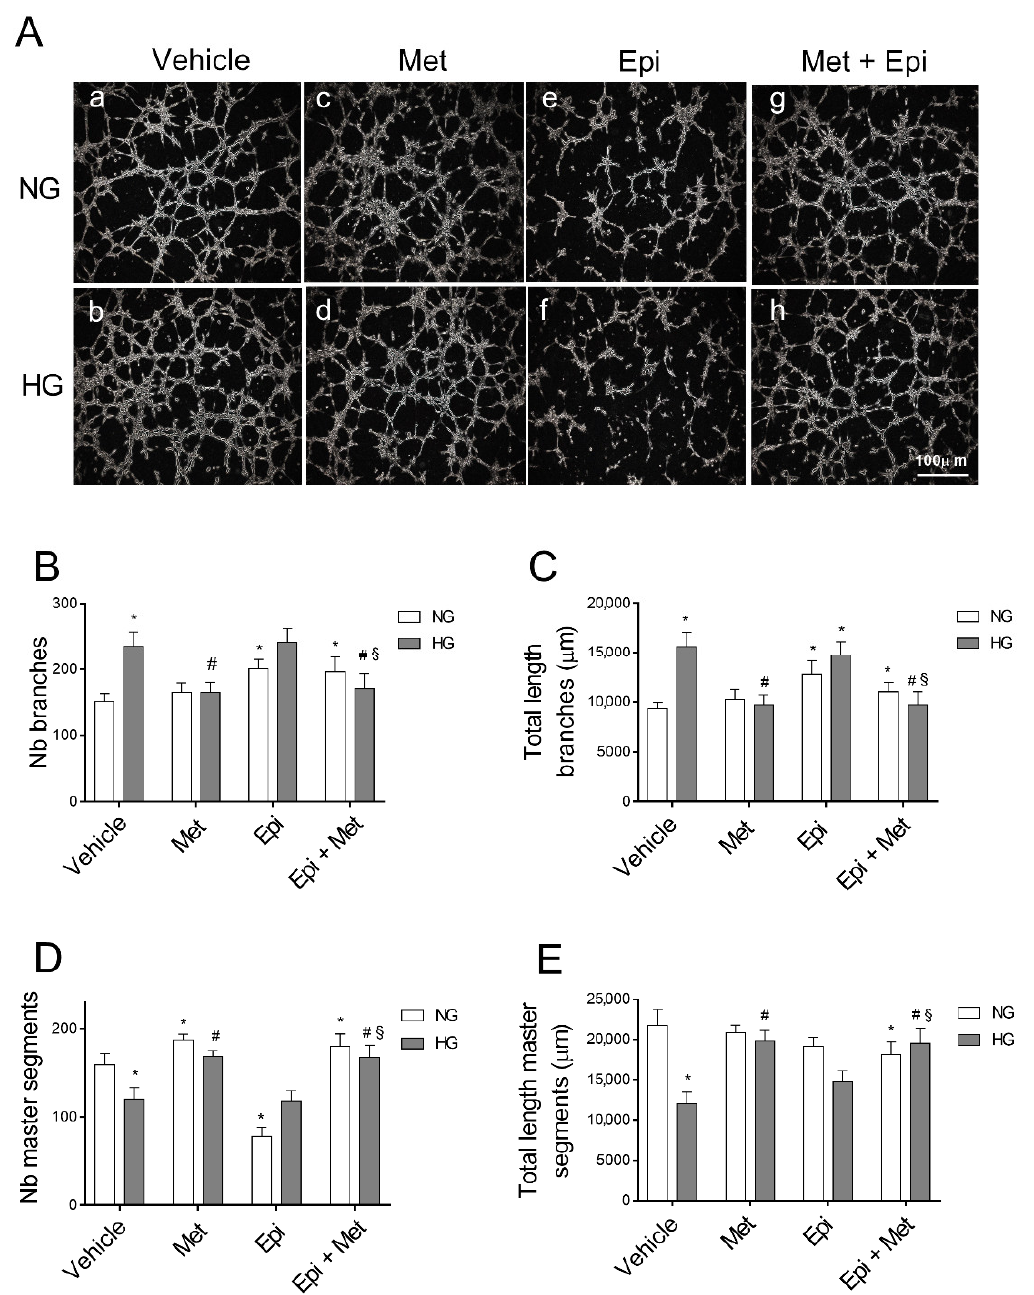
Figure 2. The role of metoprolol and epinephrine in the tube-like structures that were assessed by the tube formation assay in HREC that was stimulated with HG. HREC were seeded into 96-well plates that were coated with Matrigel at a density of 1.5 × 10 4 /well. In the presence of ( a ) normal glucose levels (NG, 5 mM) or ( b ) high glucose levels (HG, 25 mM), supplemented with metoprolol (Met, 10 μM) in absence ( c ) or in presence ( d ) of high glucose, epinephrine (Epi, 1 μM) in absence ( e ) or in presence ( f ) of high glucose, or both compounds in absence ( g ) or in presence ( h ) of high glucose. The representative microscopic field (100× magnification) showing the tube-like structures that were acquired after 4 h of cell seeding ( A ). The images were analyzed with Image J software to quantify the total number ( B ) and length ( C ) of the branches as well as total number ( D ) and length ( E ) of the master segments of the tube-like structures. The values are expressed as mean ± SD of three independent experiments with four parallel samples for group in each experiment. * p < 0.05 vs. vehicle in NG conditions; # p < 0.05 vs. HG; § p < 0.05 vs. HG-epinephrine. The non-parametric Mann-Whitney test was used for pairwise